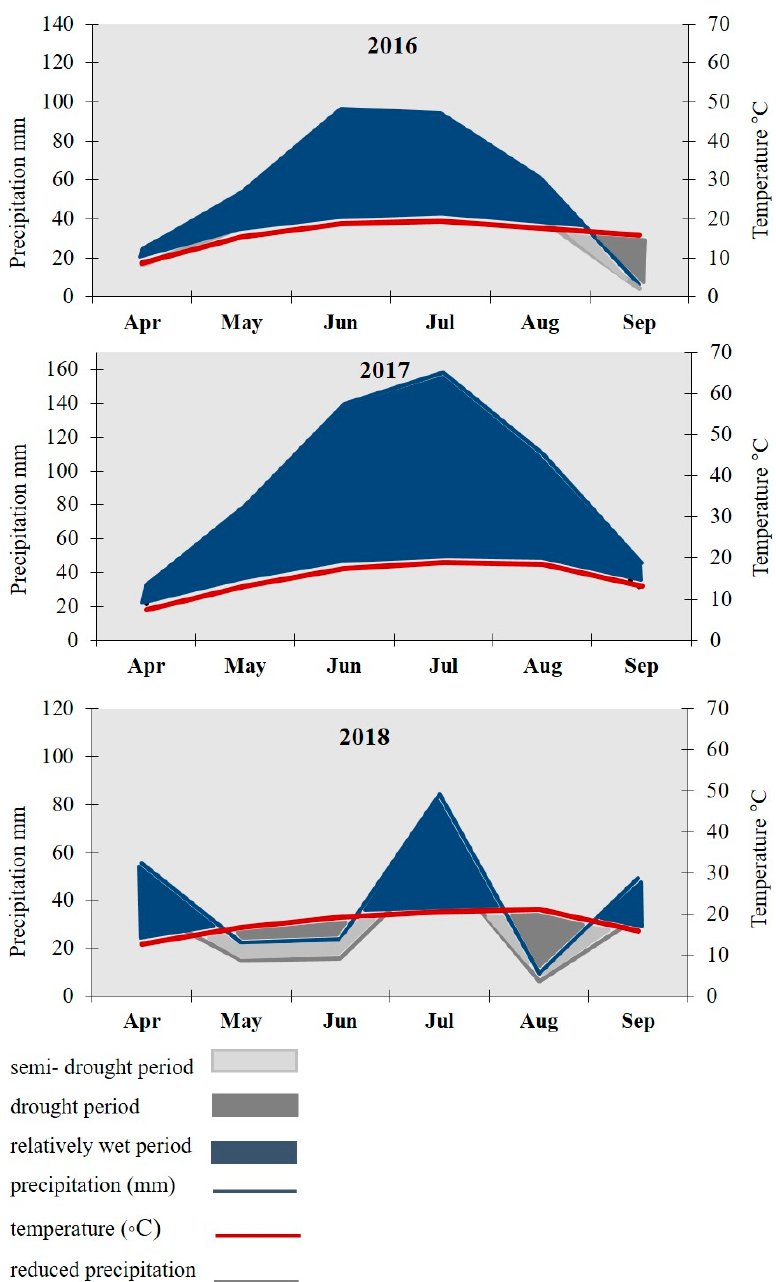
Figure 1. Climate graphs according to Walter [21] characterizing weather conditions in Gorzy ń .